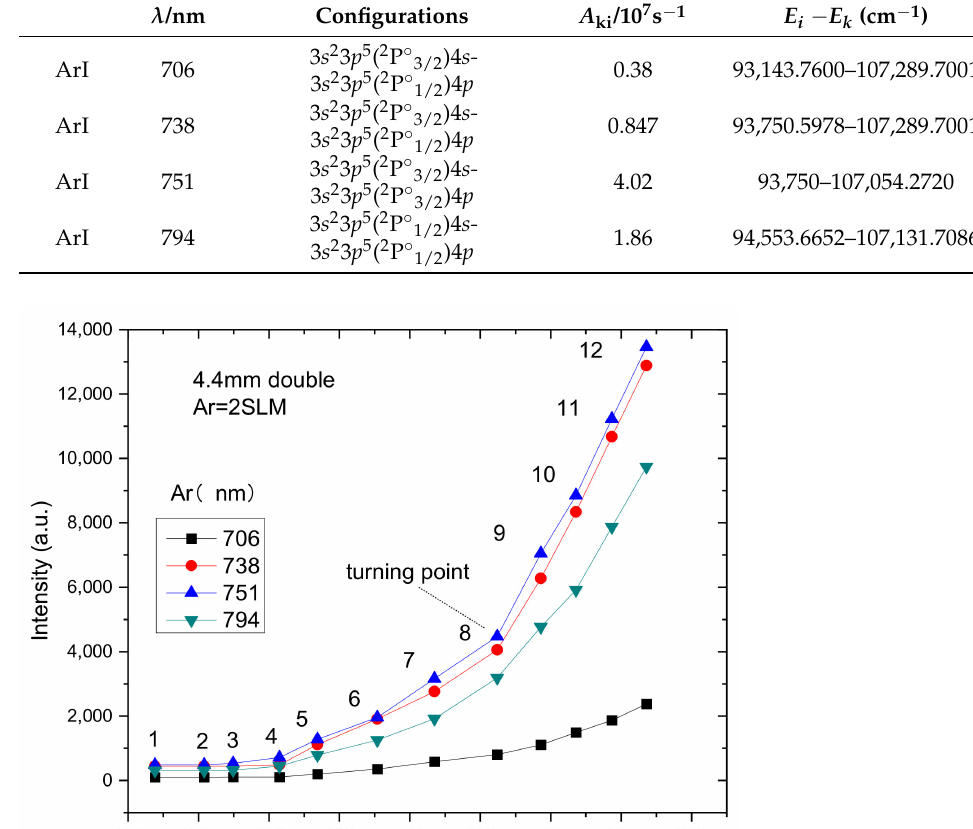
Figure 10. Species calibration of emission spectra in Figure 9. Table 1. Parameters of Ar spectrum lines studied in the experiment.